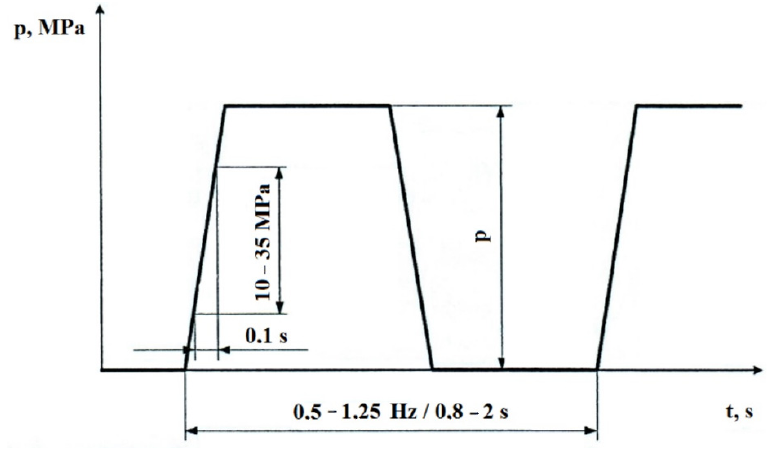
Figure 1. Theoretical course of the load